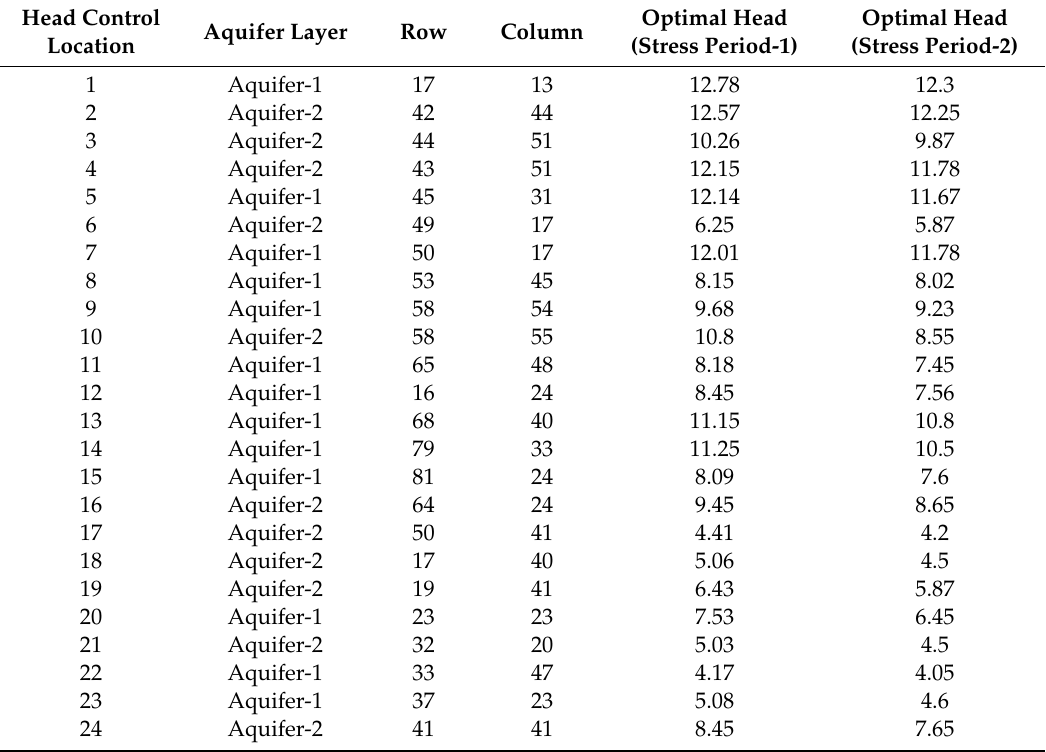
Table 2. Optimal hydraulic heads (m MSL) at the head control